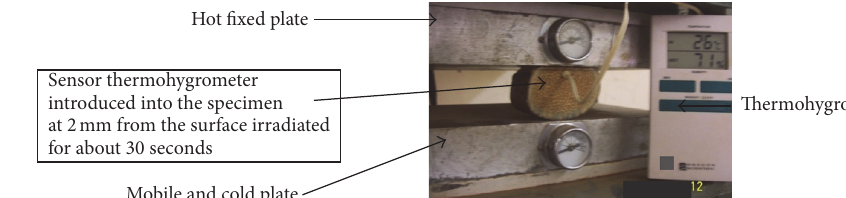
Figure 2: Thermal flash tester.